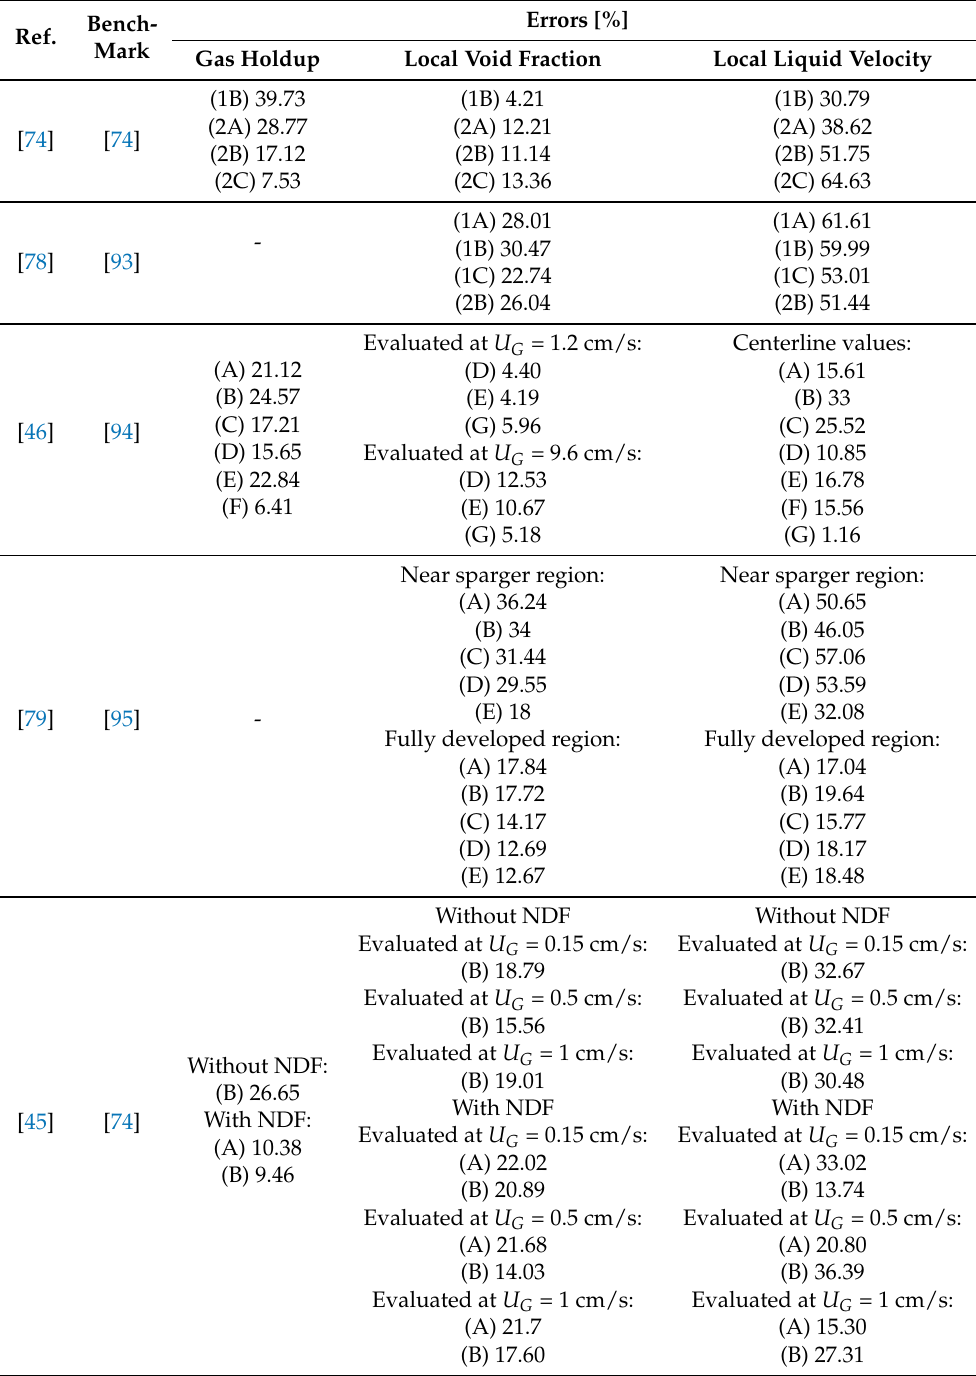
Table 8. Literature survey: model